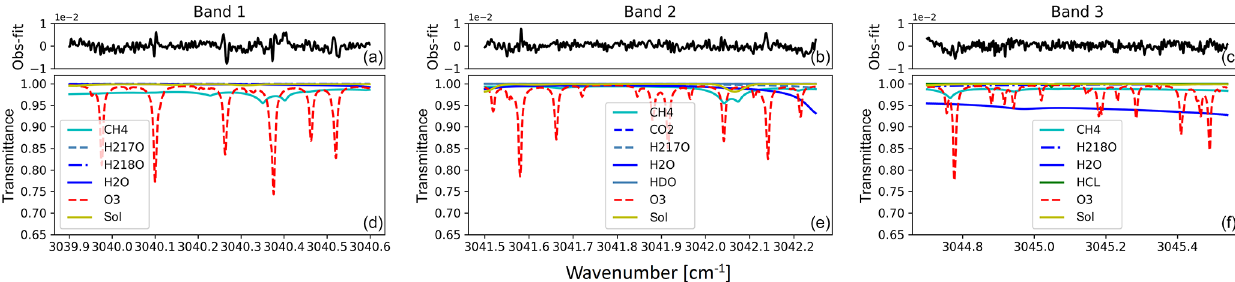
Figure 1. Example of spectral fits in the three microwindows for O 3 retrievals at Xianghe. (d, e, f) The normalized transmittance from each atmospheric species and solar lines. (a, b, c) The difference between the observed and fitted spectra (“Obs-fit”).